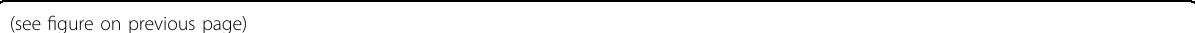
Fig. 6 cGAS – STING pathway-dependent p21 expression levels resulting in abnormal cell-cycle progression. a HeLa cells were transfected with sicGAS, and after 48 h they were subjected to western blotting with the indicated antibodies. b HeLa cells transfected with an siRNA targeting STING, and after 48 h the cell lysates were subjected to western blotting with antibodies against p21, STING, and GAPDH. c IRF3 was knocked down using RNA interference, and after 48 h cell lysates were collected. Cell lysates were subjected to western blotting with the indicated antibodies. d p53 was knocked down in HeLa cells using sip53, and micronuclei were checked 10 h after release from nocodazole by ICC (right panel); p21 levels were assessed with the indicated antibodies by western blot (left panel). The results are given as the mean ± SD from three independent experiments ( n = 300). *** P < 0.001 as assessed by Student ’ s t -test. e HeLa cells were transfected with sip53, sicGAS, or both, and then micronuclei formation was quanti fi ed after release from nocodazole using ICC (right panel). cGAS, p53, and p21 levels were assessed with the indicated antibodies using western blot. The results are given as the mean ± SD from three independent experiments ( n = 300). *** P < 0.001 as assessed by Student ’ s t -test. f HeLa cells were transfected with siSTING and then were subjected to a double thymidine block with 2 mM thymidine for 40 h. Six hours after release from the DTB, quanti fi cation of the percentage of mitotic cells with condensed chromosomes was performed by aceto-orcein staining at the indicated time points. The results are given as the mean ± SD from three independent experiments ( n =